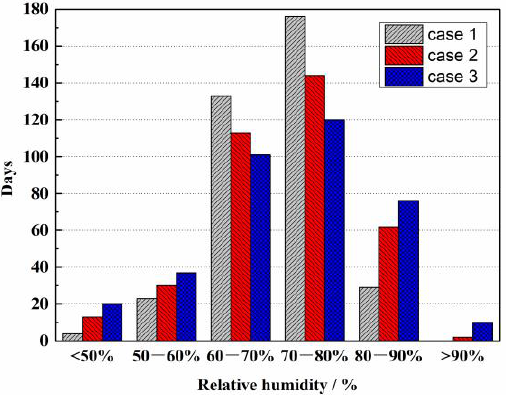
Figure 11. Relative humidity distribution of indoor air in one year.